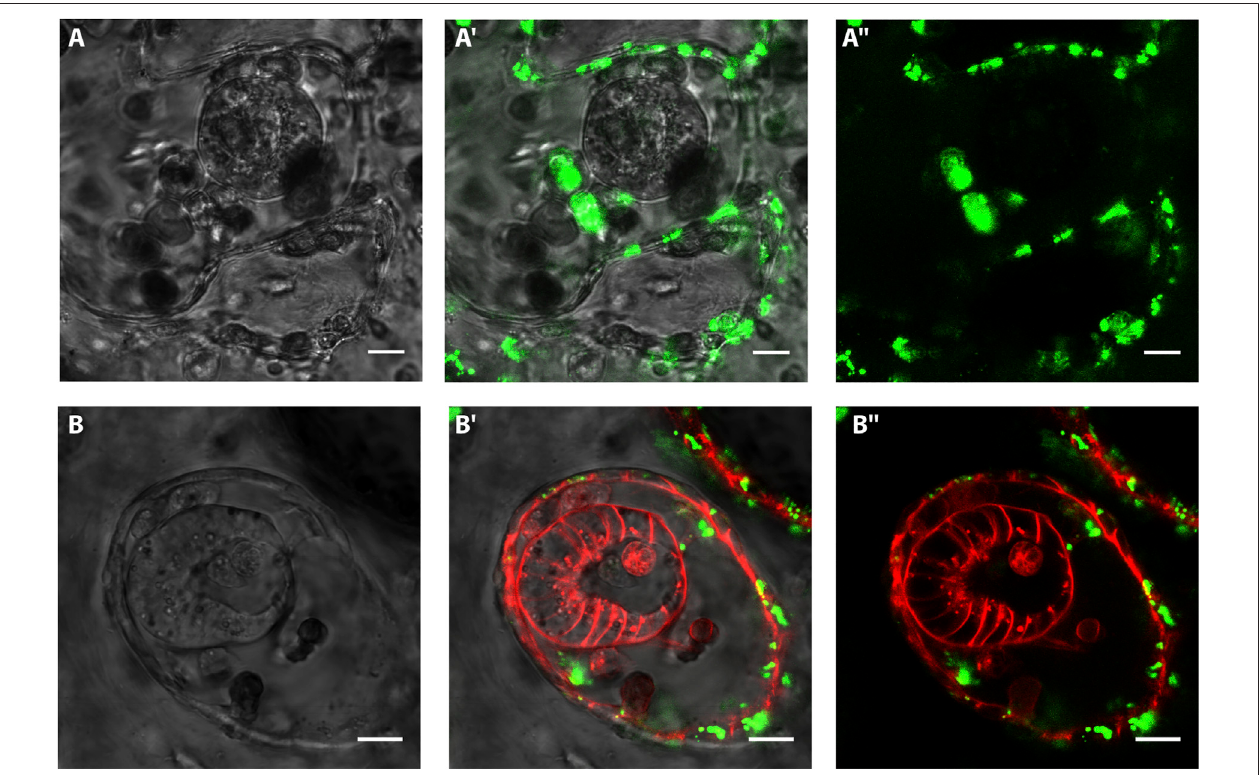
FIGURE5| Invivo labelingofvasculatureepitheliumandintravascularvesicleswithBSAandFMR4-64ConfocalimagesofvascularbudsafterinjectionofBSAand FM4-64. Green: BSA Alexa Fluor 488 conjugate; red: FM4-64. (A – A ’’ ) Confocal images of aspherical-shaped cluster of cells detected within 3 days after microsurgery. The vasculature islabeled withFITC-conjugated BSA(green). (B – B ’’ ) Confocal images ofapolarizedvesicle detected within3 days after microsurgery. Thevasculature is labeled with FITC-conjugated BSA (green), the cell membranes are labeled with FM4-64 (red). Scale bar= 10 μ .